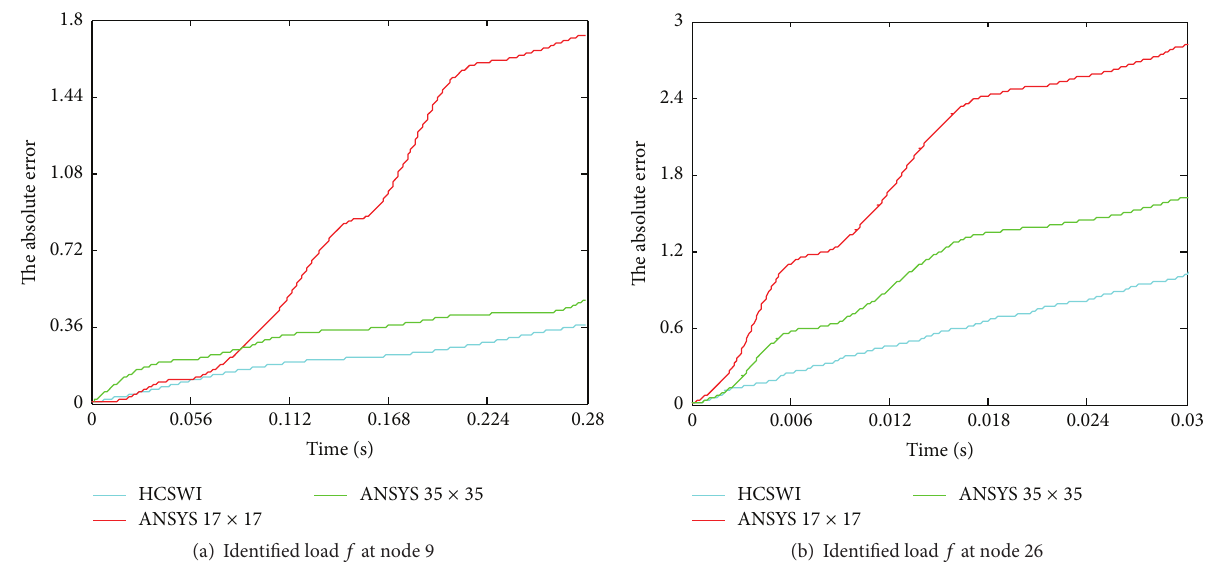
Figure 24: The absolute error with excitation 𝑓 applied at nodes 9 and